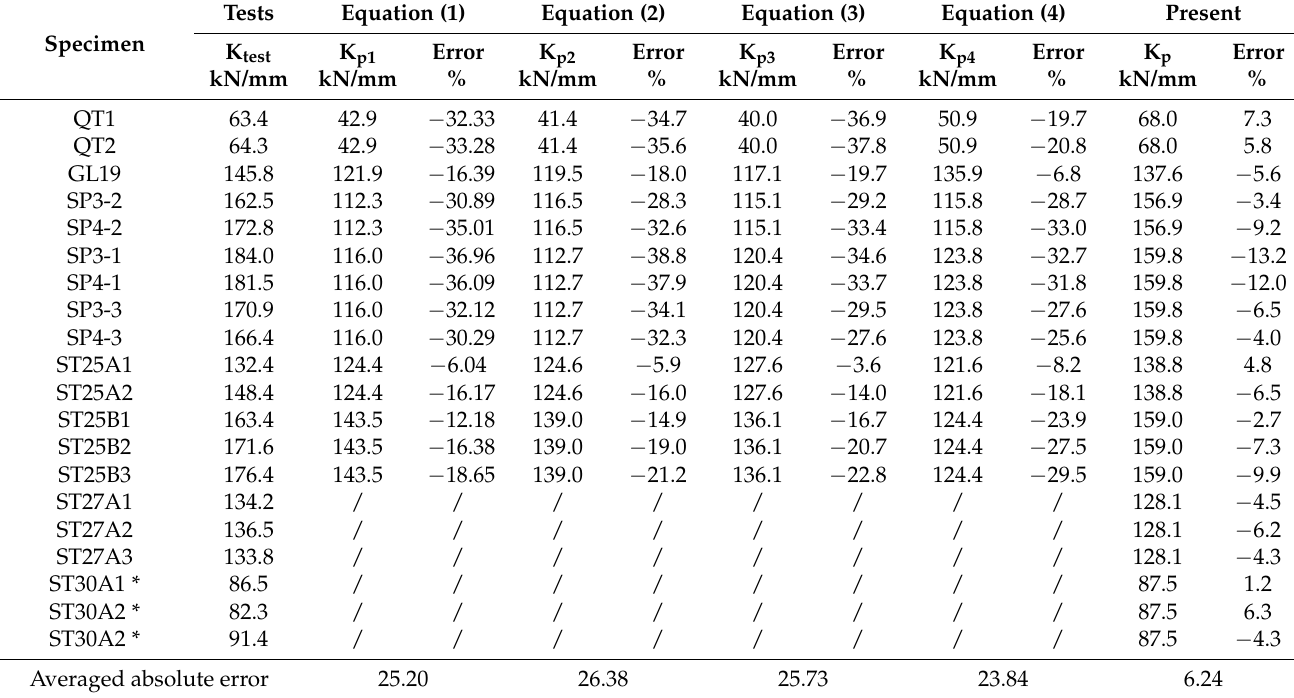
Table 3. The comparison of initial shear stiffness between test results, existing formulae, and the present